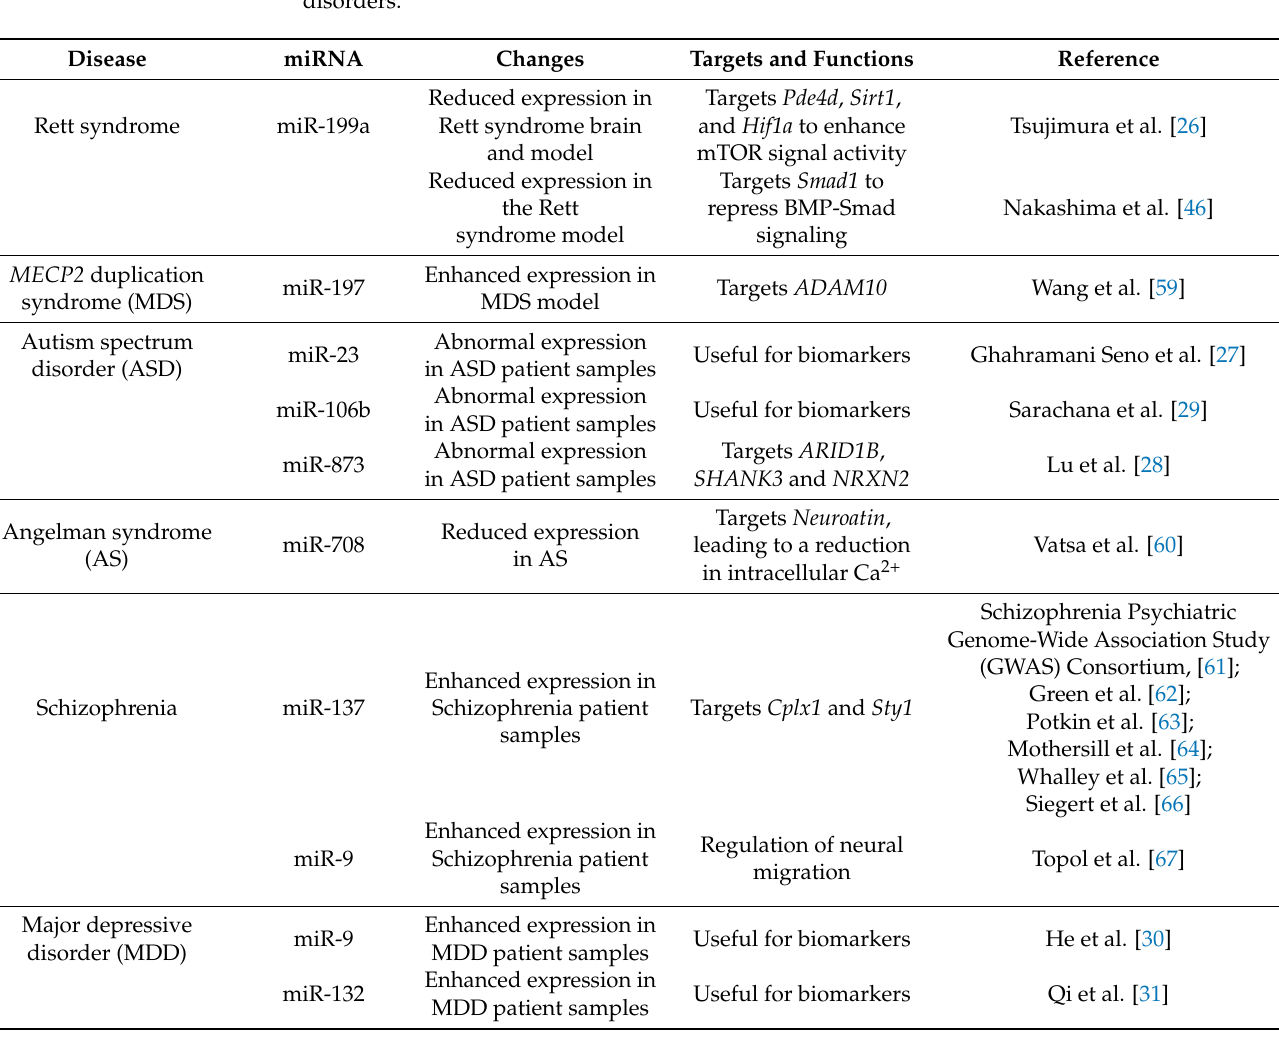
Table 2. microRNAs (miRNAs) involved in the pathogenesis of neurodevelopmental and psychiatric